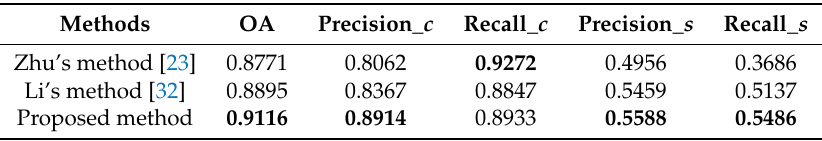
Table 5. Statistical results of different cloud and cloud shadow detection